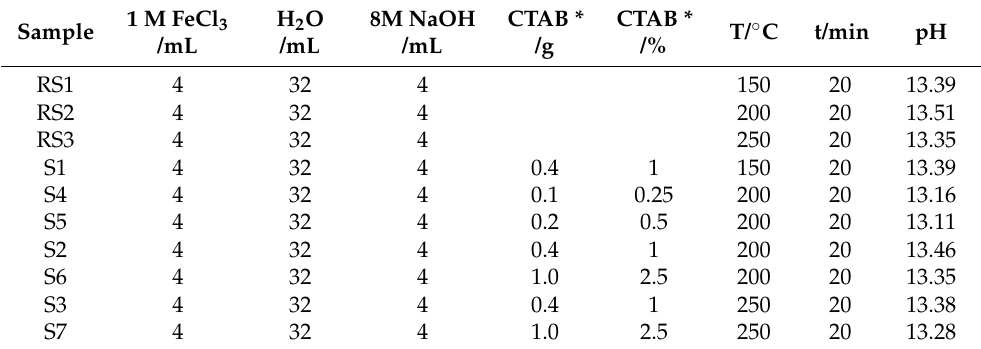
Table 1. Experimental conditions for iron oxide particles’ preparation.